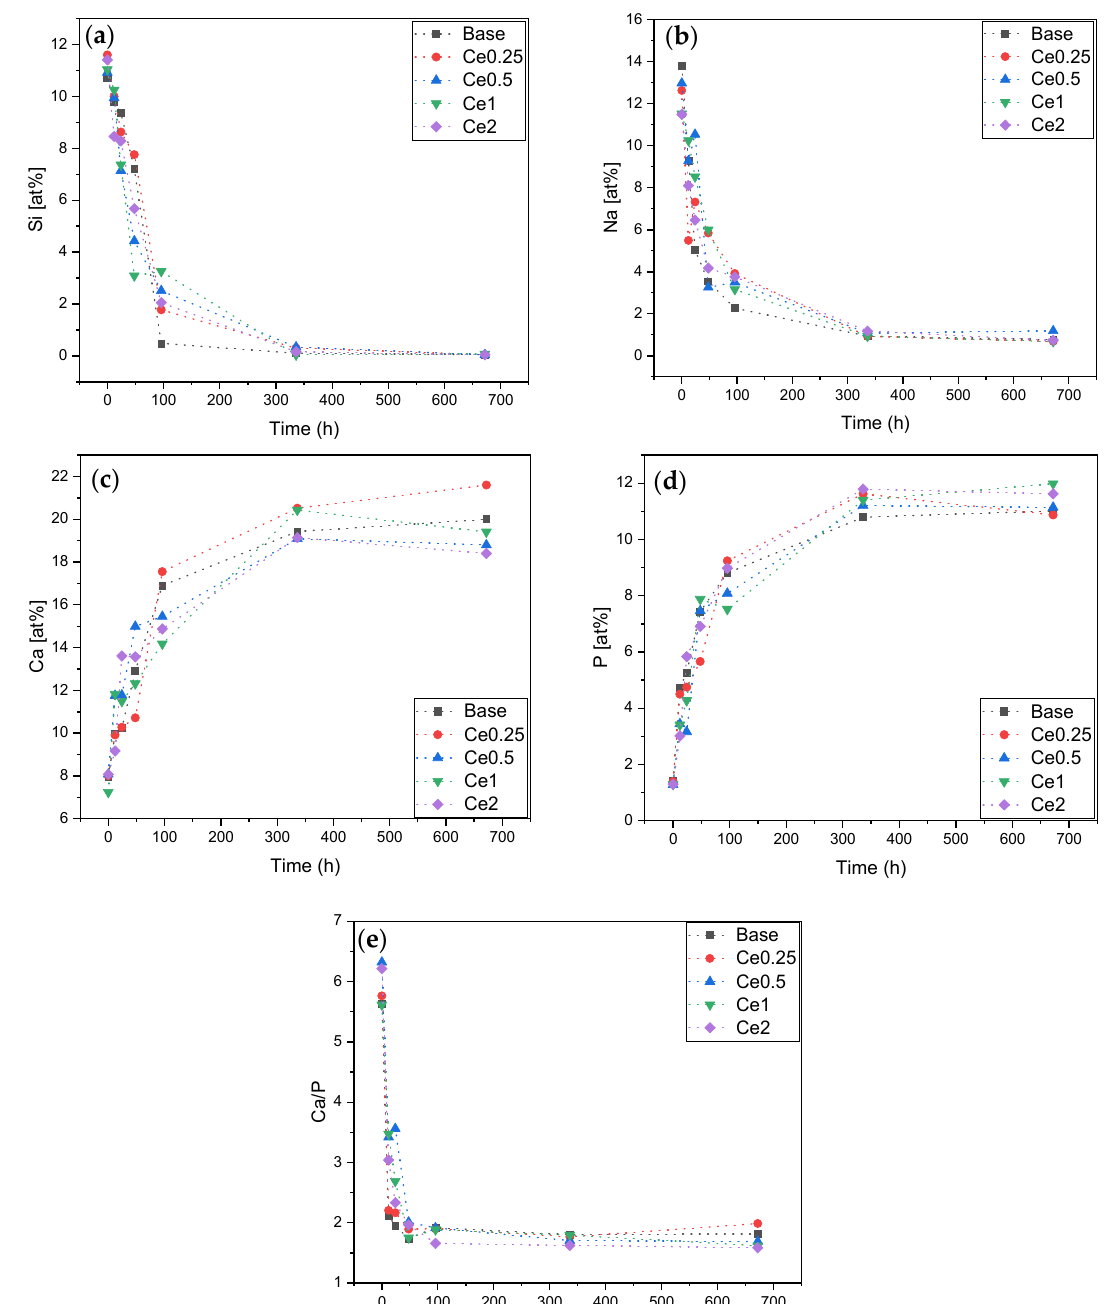
Figure 4. EDS of pellets surface after SBF immersion (12 h, 24 h, 48 h, 96 h, 336 h, and 672 h). ( a ) Si at%; ( b ) Na at%; ( c ) Ca at%; ( d ) P at%; and ( e ) Ca/P ratio.